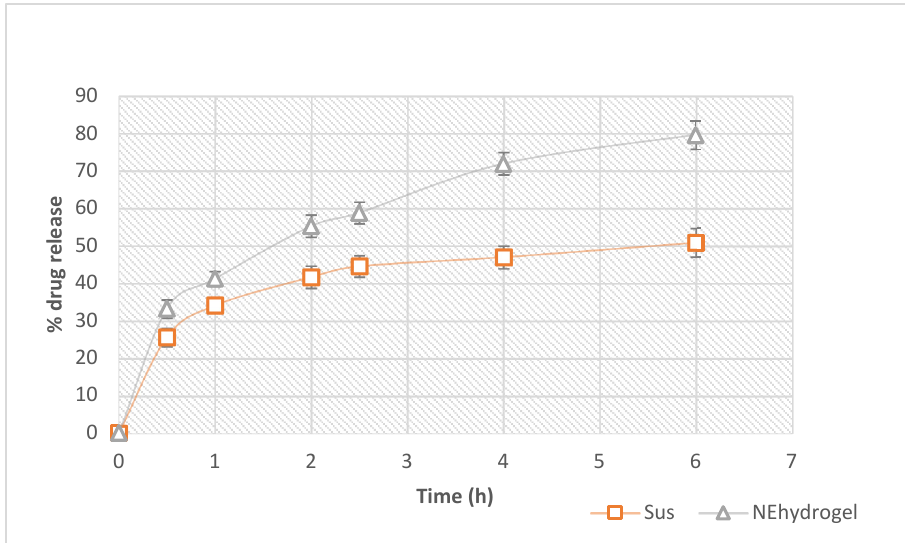
Figure 8. Comparison of release profiles of prepared nanoemulsion hydrogel and control suspension. NE hydrogel: nanoemulsion hydrogel; Sus: resveratrol suspension.